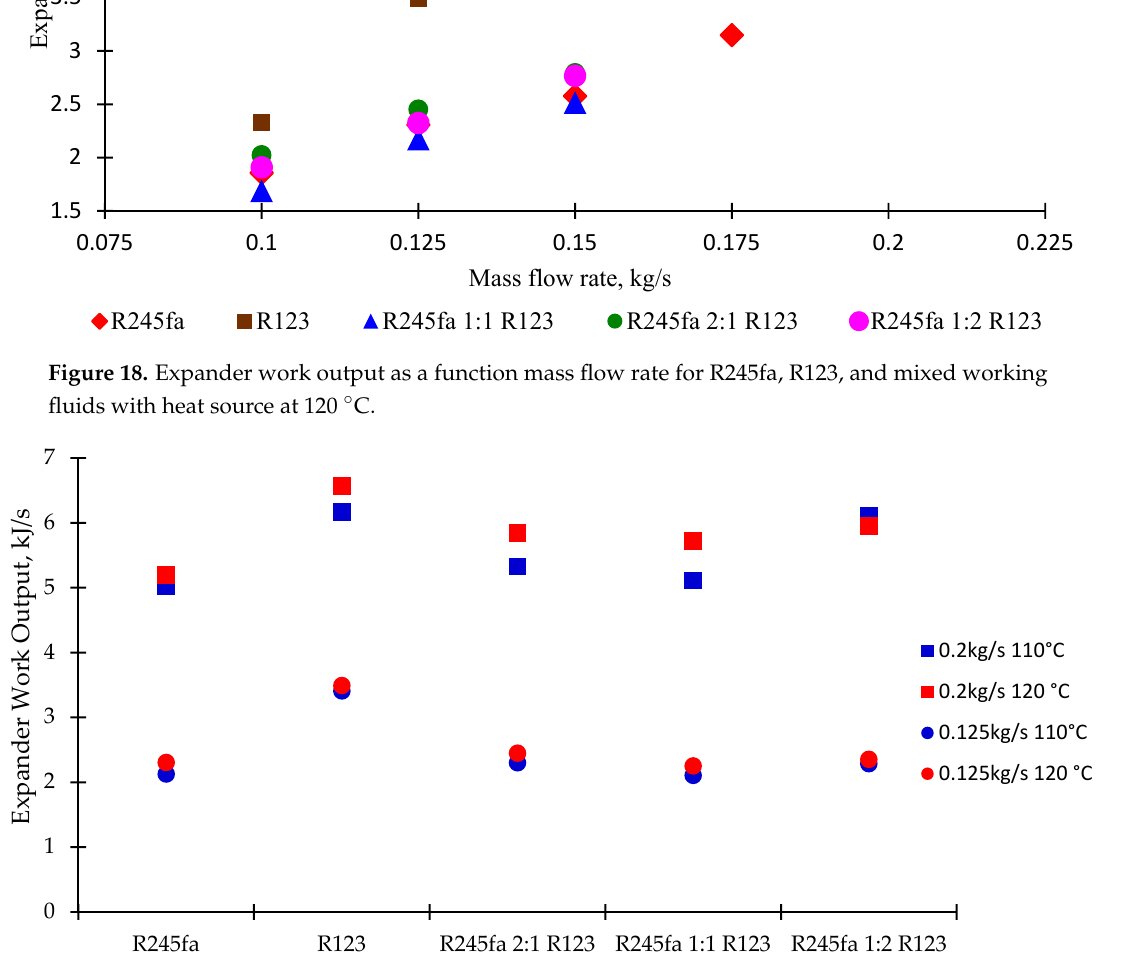
Figure 19. Expander work output with mass flow rate of 0.125 kg/s on a heat source 110 °C and 120 °C, compared to a mass flow rate of 0.2 kg/s on a heat source 110 °C and 120 °C.